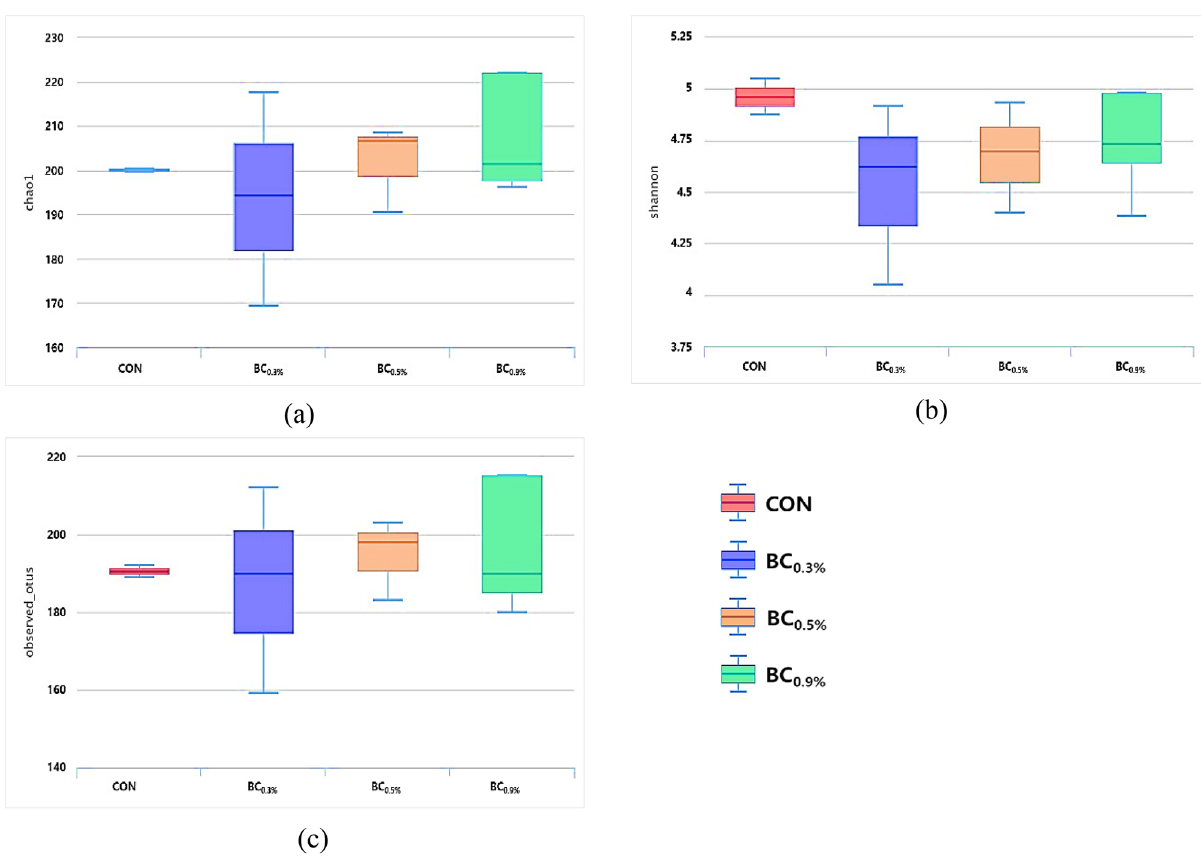
Figure 1. Boxplot representation of alpha diversity indices: ( a ) chao1, ( b ) Shannon, and ( c ) observed OTUs, between treatment groups. Alpha-diversity metrics visualization were done in MetaCOMET 24 and computed using QIIME 25 . CON (no buffer added); BC 0.3% (0.3% buffer); BC 0.5% (0.5% buffer); BC 0.9% (0.9%